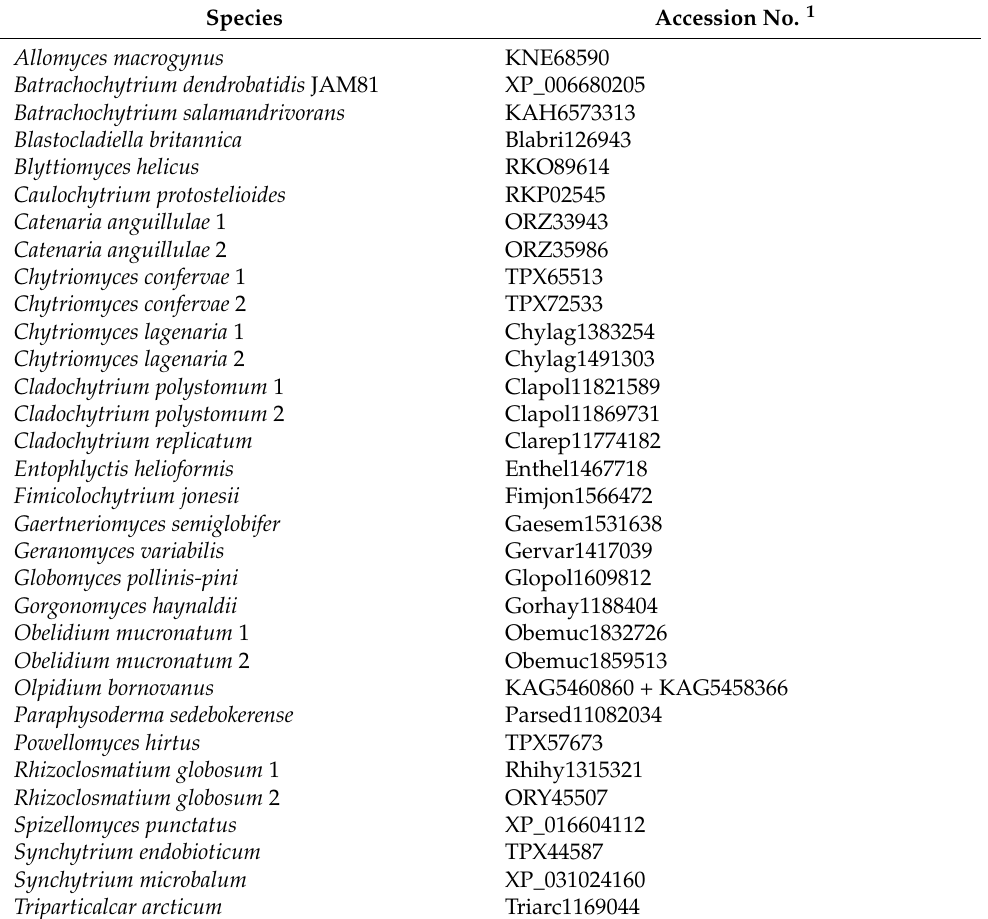
Table 1. Accession Numbers of fungal proteins shown in Figures 4 and 5.